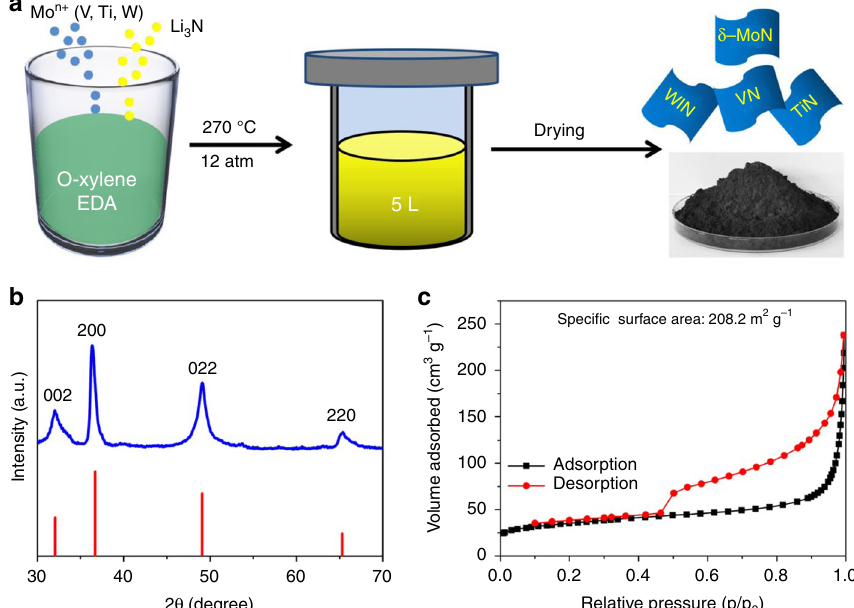
Fig. 1 Synthesis and crystal phase of the δ − MoN nanosheets. a Schematics illustrating the synthesis of highly crystalline δ − MoN nanosheets. b XRD pattern and c N 2 adsorption and desorption isotherms of the δ − MoN